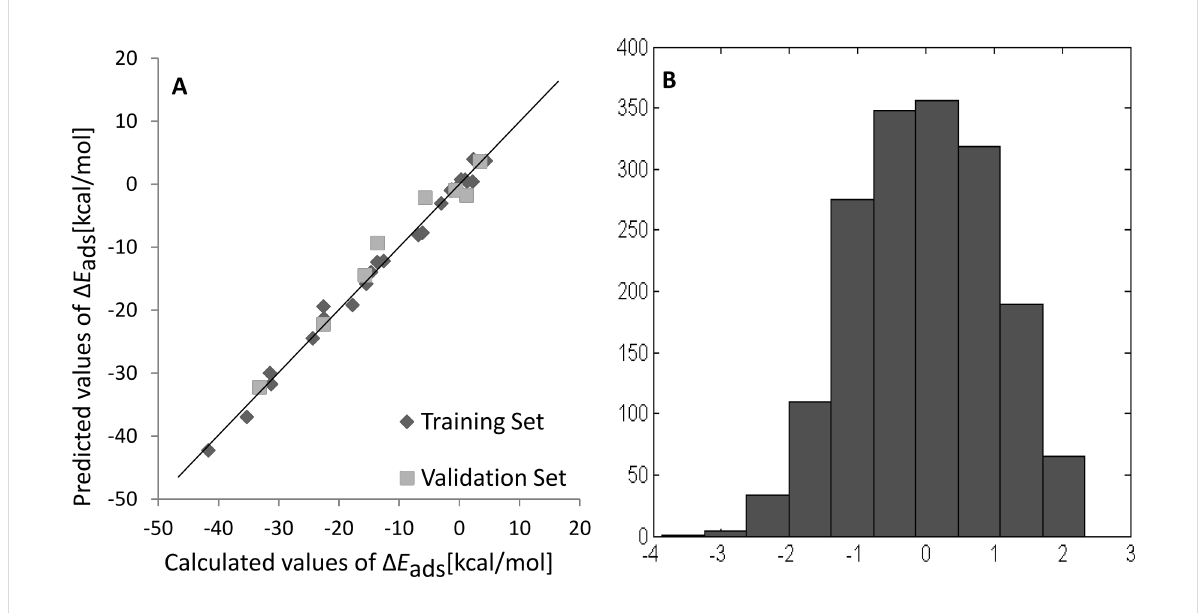
Figure 1: a) Plot of calculated and predicted values of Δ E ads energy. b) Histogram of calculated and predicted values of Δ E ads .